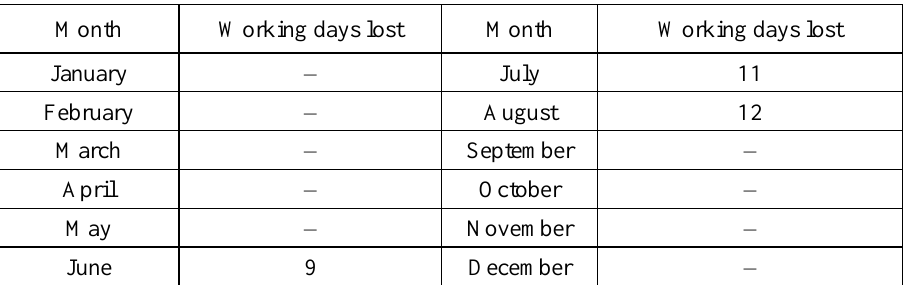
Table 3. Anticipated Monthly Working-Day Lost Due to Adverse Rainfall